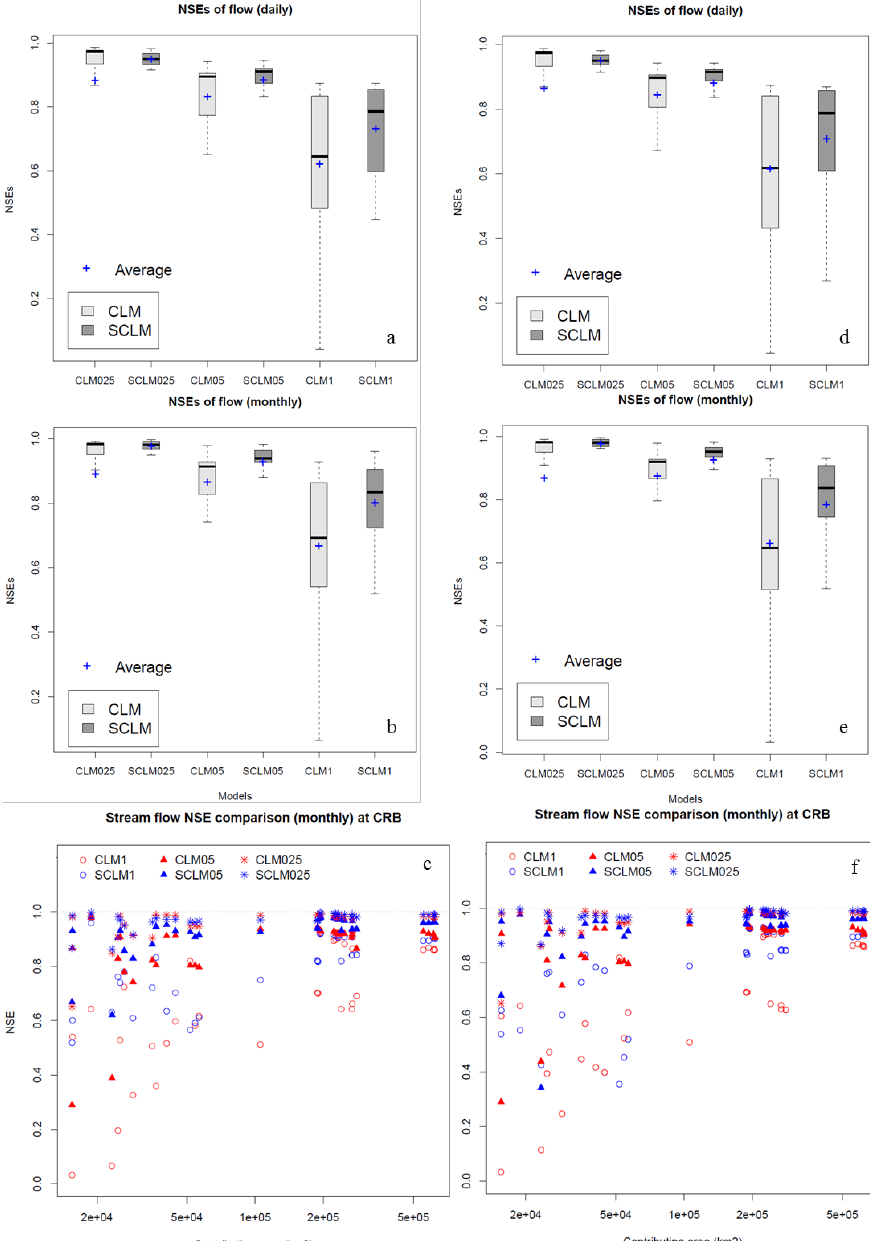
Figure 10. Statistics of (a and b) area-normalized and (d and e) nonnormalized NSEs of streamflow at different temporal scales and (c and f) NSEs of monthly streamflow across the spatial scale over USGS stations with drainage area greater than 15000km 2 in the